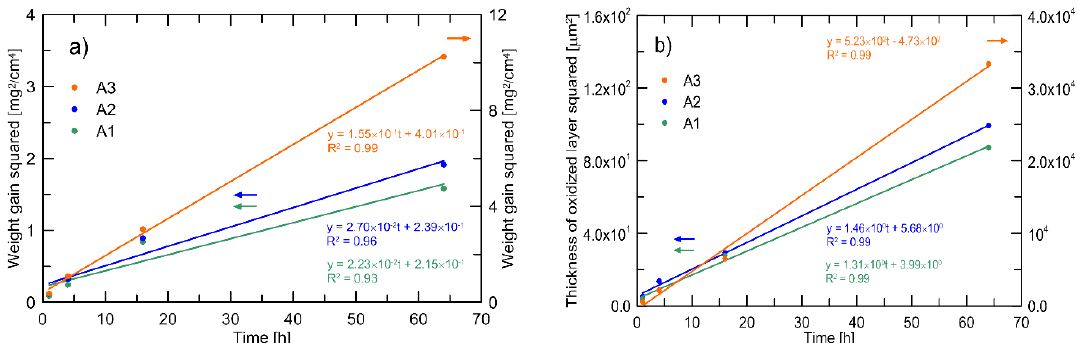
Figure 4. The isothermal kinetics of the weight gain ( a ) and of the thickness of the oxidized layer ( b ) for grades A1, A2 and A3 with Al contents 5.5 wt.%, 2.0 wt.% and 0.3 wt.%, respectively.